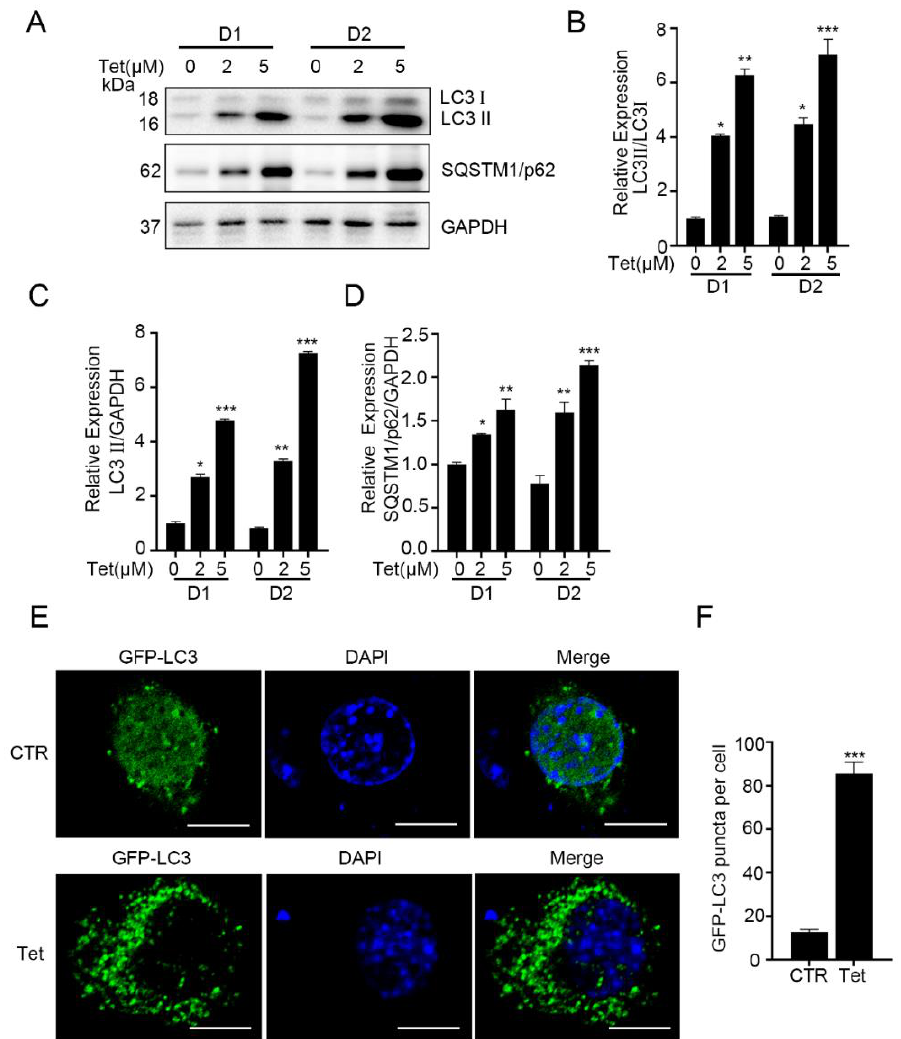
Figure 3. Tetrandrine induces autophagosome accumulation in differentiating C2C12 myoblasts. ( A ): Representative Western blots showing LC3 and SQSTM1/p62 levels in C2C12 myoblasts after 1 or 2 d of differentiation in the presence or absence of tetrandrine. ( B – D ): The expression ratios of LC3II/LC3I, LC3II/GAPDH and SQSTM1/p62/GAPDH in A were quantified using ImageJ 1.46r software (Bethesda, MD, USA) (https://imagej.nih.gov/ij, accessed on 29 June 2022). n = 3, * p < 0.05, ** p < 0.01 and *** p < 0.001. ( E ): GFP-LC3 puncta in C2C12 cells transfected with ad-GFP-LC3 and differentiated for 1 d in the presence or absence of tetrandrine. The nuclei were counterstained with DAPI (blue). Scale bars: 10 µ m. ( F ): The numbers of GFP-LC3 puncta in E were quantified. n = 3, *** p < 0.001. LC3, microtubule-associated protein 3; SQSTM 1, sequestosome 1; CTR, vehicle-treated control cells; Tet, tetrandrine; GFP, green fluorescent protein.